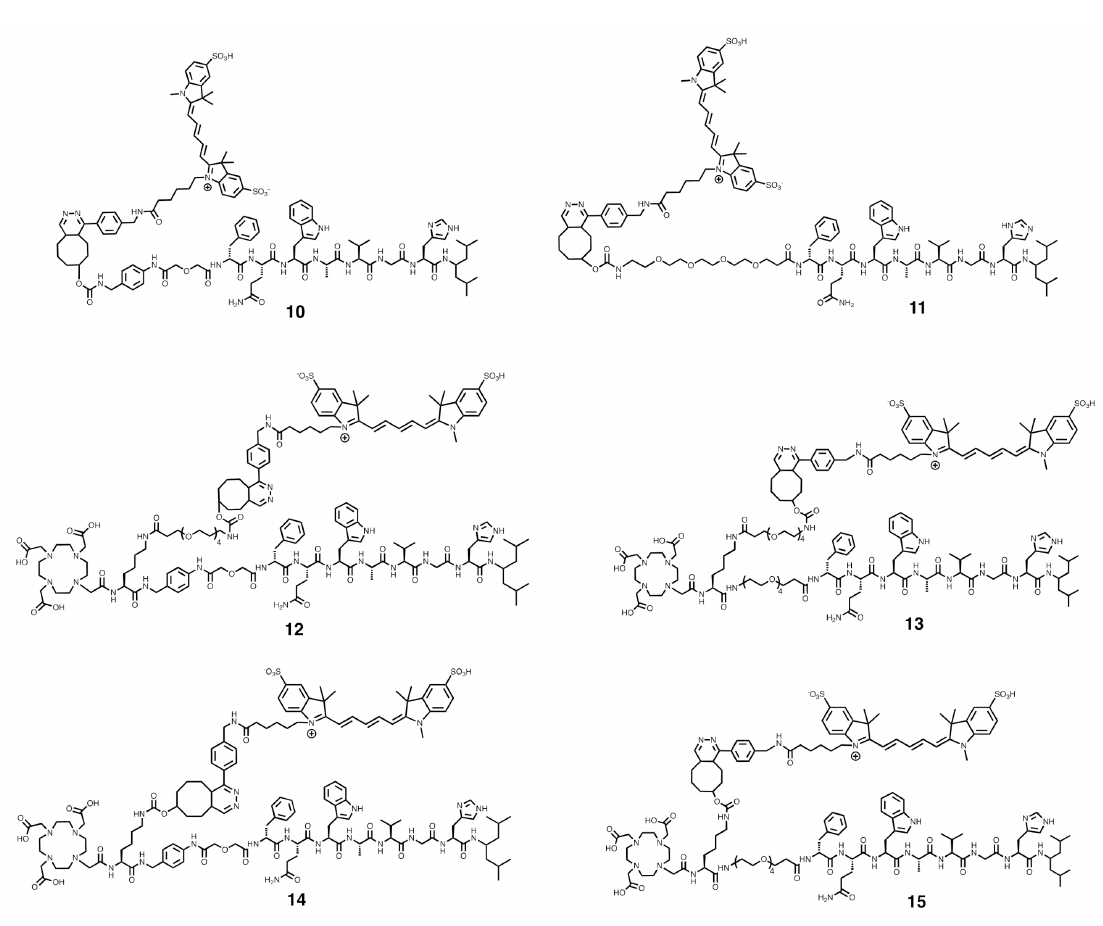
Figure 1. The chemical structures of the two mono-, 10 and 11 , and four dual-, 12 , 13 , 14 and 15 modality probes obtained via the IEDDA click reaction. Table 1. RCY, LogD 7.4 and stability in PBS and mouse serum of [ 111 In]In- 12 – 15